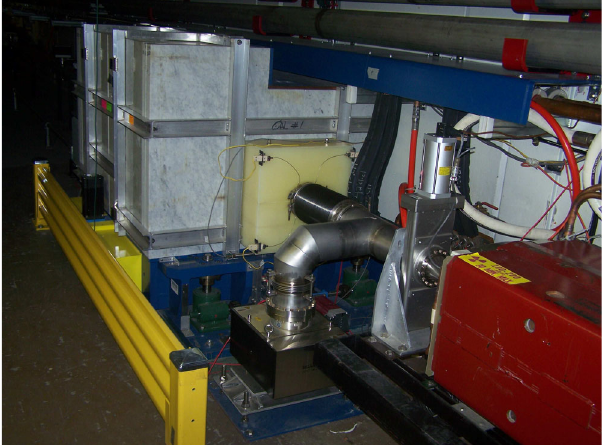
FIG. 7. One of four secondary collimators that employ a thick stainless steel vacuum chamber surrounded by a steel absorber to contain the shower particles. Radiation shielding for personnel is provided by 12 cm of marble placed on the top, ends, and aisle side of the collimator. At the upstream end a polyethylene block reduces neutron flux to upstream magnet coils. At the down- stream end, masks are placed to absorb small angle outscattered